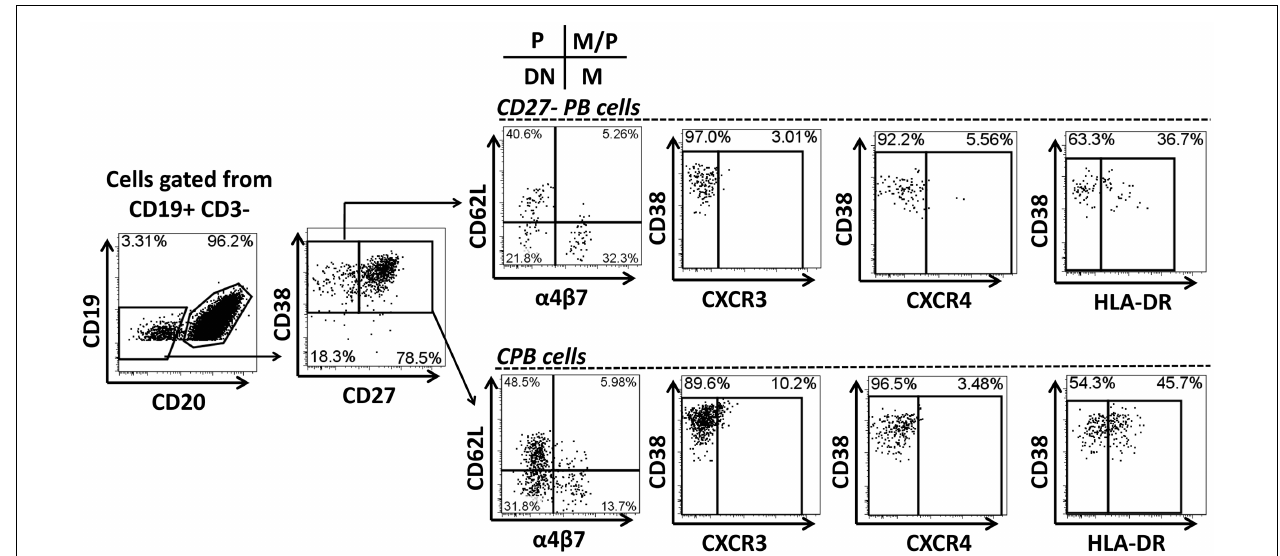
preferentially to peripheral lymphoid tissues. M indicates cells expressing only integrin α 4 β 7, homing preferentially to the gut mucosa. M/P indicates cells co-expressing integrin α 4 β 7 and CD62L (dual homing potential). DN indicates cells expressing neither CD62L nor integrin α 4 β 7. Expression of other homing molecules including CXCR3 and CXCR4 as well as the activation marker HLA-DR were also evaluated in CD27-PB and CPB subsets.